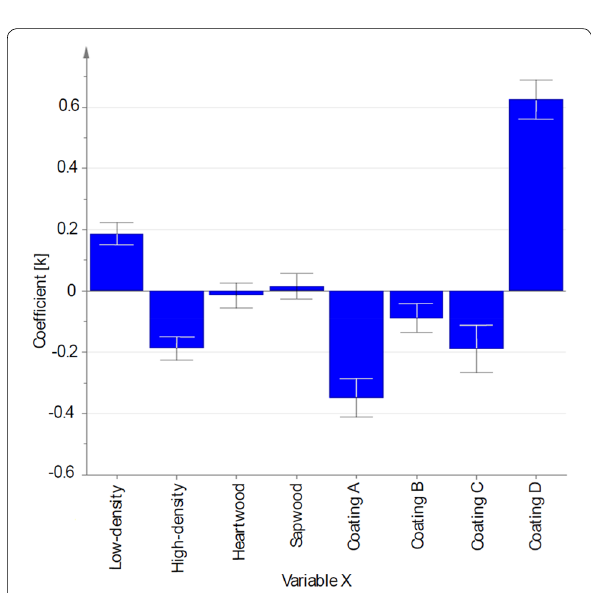
Fig. 6 PCA score plot describing the MC with adjusted coordinates (PC1 and PC2) for maximum variation between the replicates. Replicates close in space have a similar MC. A–D: coating systems described in Table